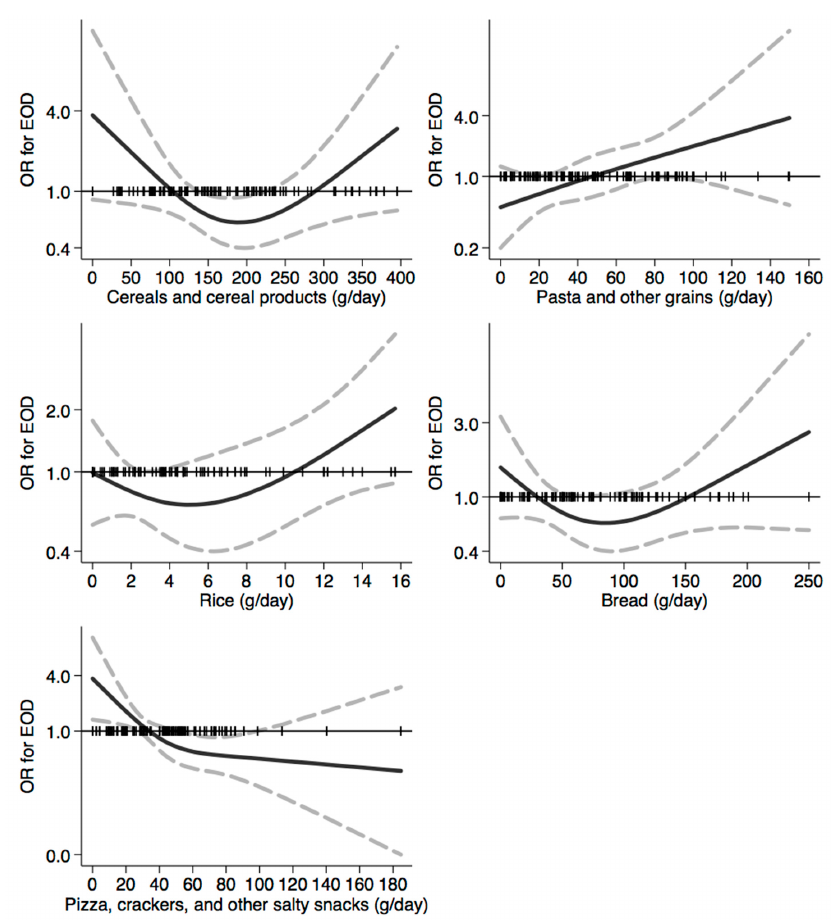
Figure 1. Spline regression analysis of early ‐ onset dementia (EOD) risk for increasing intake of cereals and cereal products. The black line indicates odds ratios for dementia risk; dash gray lines are 95% confidence limits; the reference line at 1.0 with black spikes indicates the distribution of participant intake.